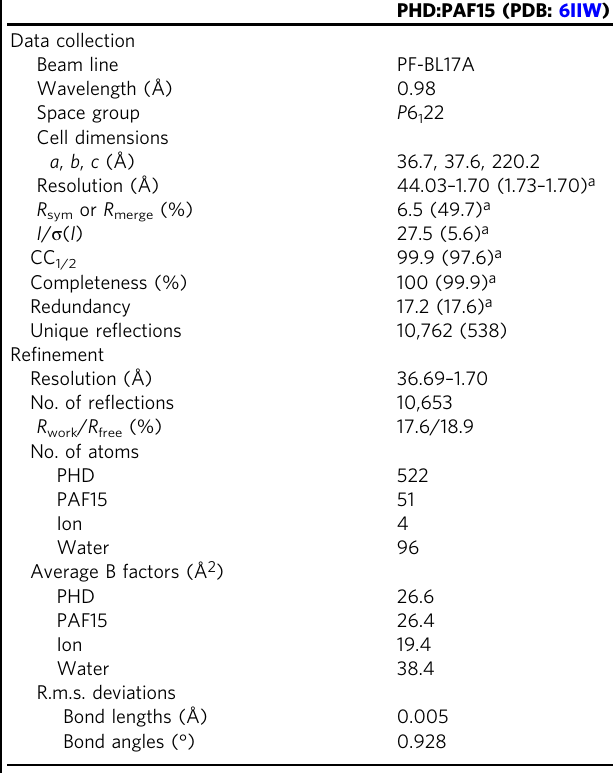
Table 1 Data collection and re fi nement